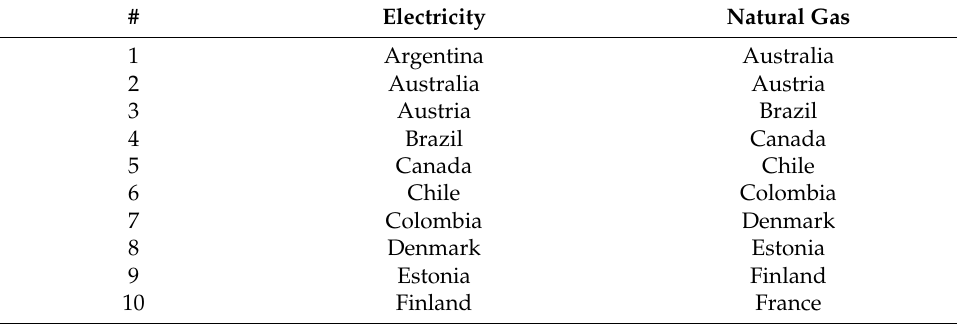
Table 2. Selected countries analyzed. Source: Drawn up by the